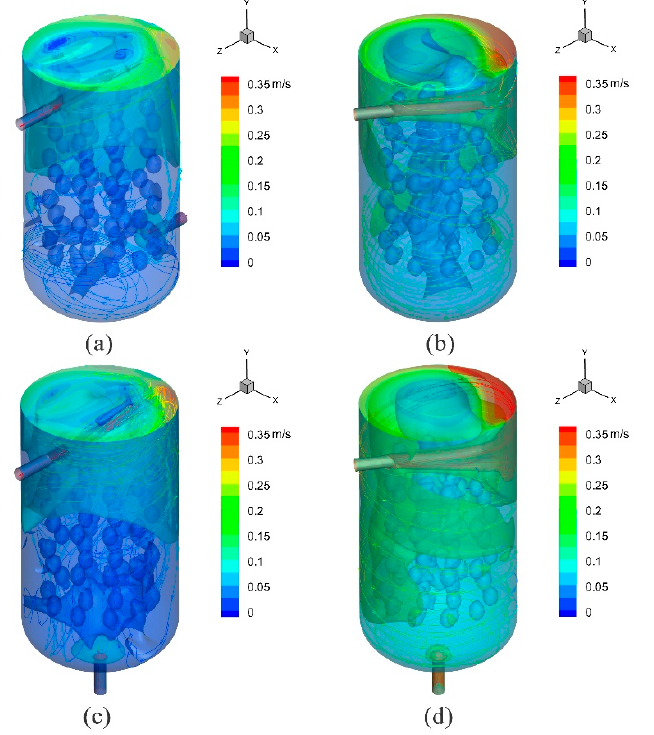
Figure 7. Three-dimensional iso-faces and stream trace colored according to velocity magnitude: ( a ) case c, ( b ) case f, ( c ) and ( d ) case h and i. ( a ) case c, ( b ) case f, ( c , d ) case h and